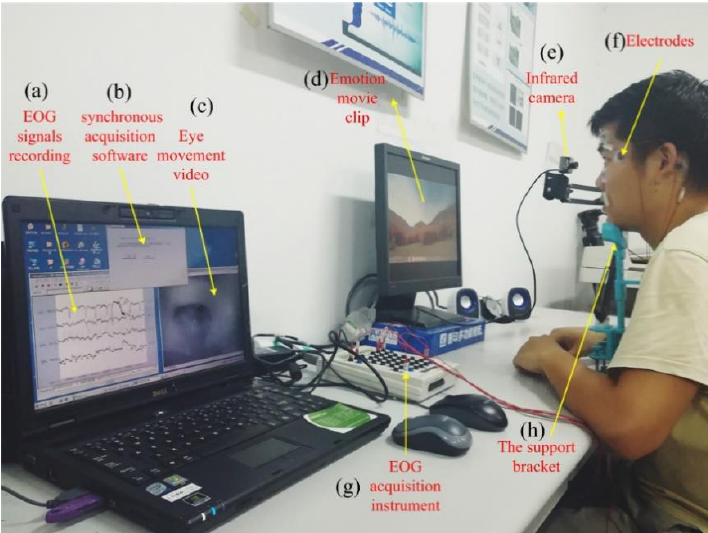
Figure 9. The real experimental scene. ( a ) EOG signals collection and displaying system, ( b ) the synchronous acquisition software, ( c ) the recording eye movement video, ( d ) Emotion movie clips, ( e ) the infrared camera, ( f ) six bio-electrodes used to acquire the EOG signals, ( g ) EOG signals amplifier (Neuroscan), ( h ) the support bracket for holding head.